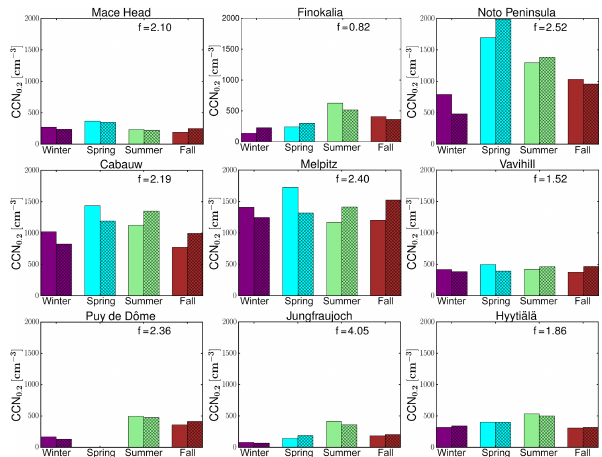
Figure 2. Monthly ensembles for the years 2011–2015 of the CCN number concentration for supersaturation 0.2% (CCN 0 . 2 ) . The CCN 0 . 2 obtained from observational data is shown with symbols. The continuous bold blue and red lines show the monthly median and mean of all models, respectively. The shaded area shows 25% and 75% of the model results, while the green dashed lines show the minimum and maximum values of all models.